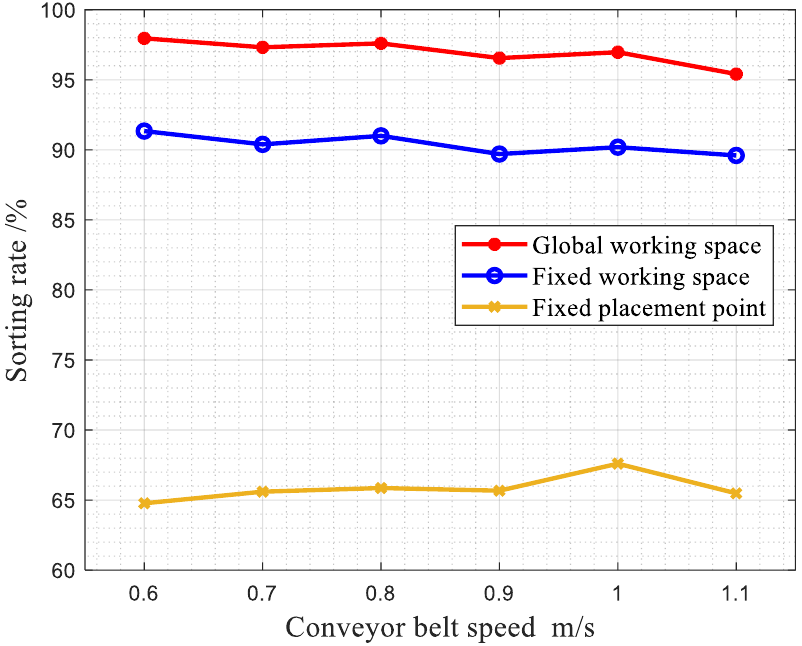
Figure 17. Sorting rate variation of the three sorting methods at different belt speeds.